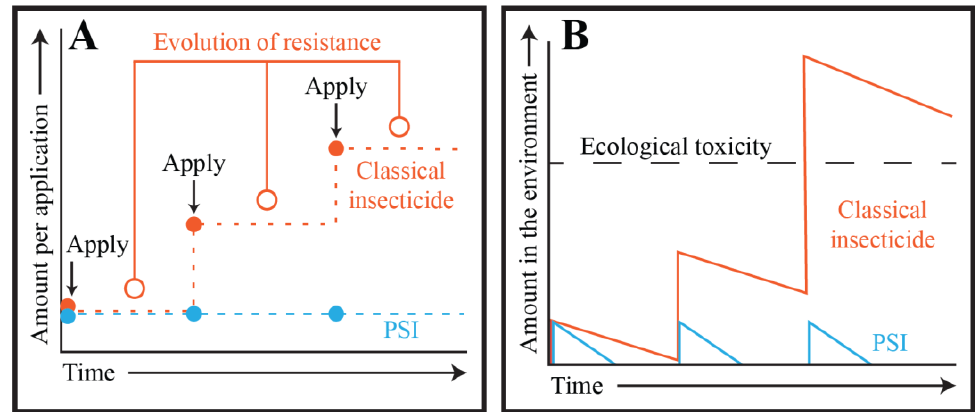
Figure 7. Photosensitive insecticides avoid the pesticide treadmill and environmental accumulation. ( A ) Resistance evolves (open orange circles) against classical insecticides following their repeated application (closed orange circles) because of selective pressure on their highly specific neurological targets whereas the evolution of resistance against PSIs following their repeated application (closed blue circles) is unlikely because of their broad mechanism of action that relies on oxidative damage. Therefore, to achieve the same level of insect control with classical insecticides, higher dosages are progressively applied as the populations gain resistance, whereas this is unnecessary for PSIs. ( B ) Classical insecticides persist longer in the environment and require increased dosage application to manage resistant populations. Therefore, classical insecticides accumulate over time and eventually lead to environmental damage, whereas PSIs do not.